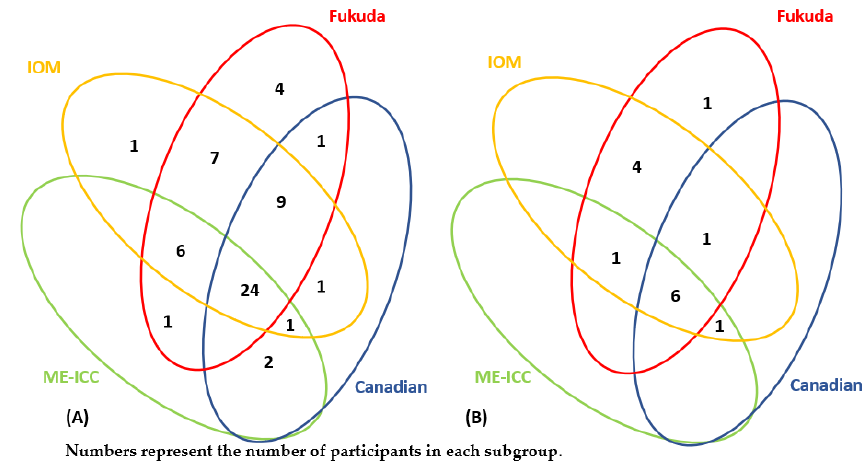
Figure 1. ( A ) The overlap between the subgroups that met different diagnostic criteria of ME/CFS in the first cohort (ME/CFS). ( B ) The overlap between the subgroups that met different diagnostic criteria of ME/CFS in the second cohort (post-COVID ME/CFS). Numbers represent the number of participants in each subgroup.